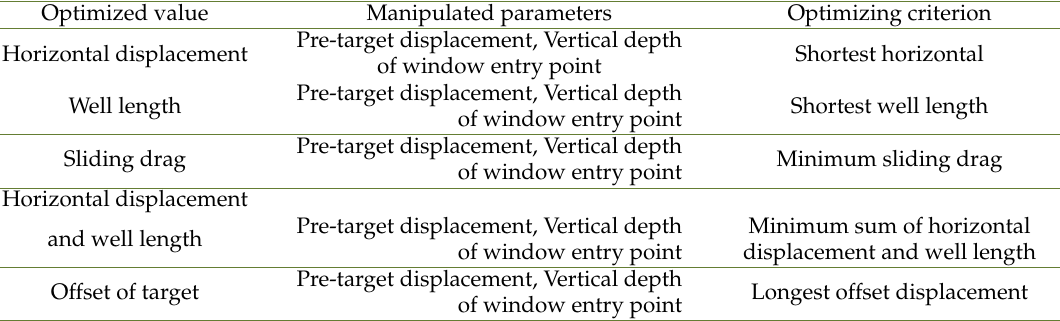
Table 11. Different well path optimization methods comparing